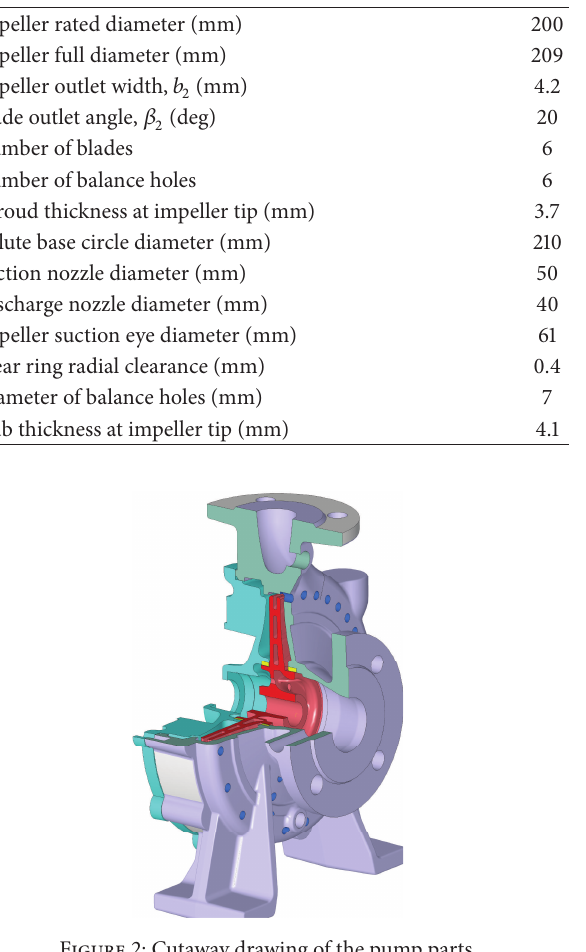
Table 1: Main dimensions of the investigated pump.